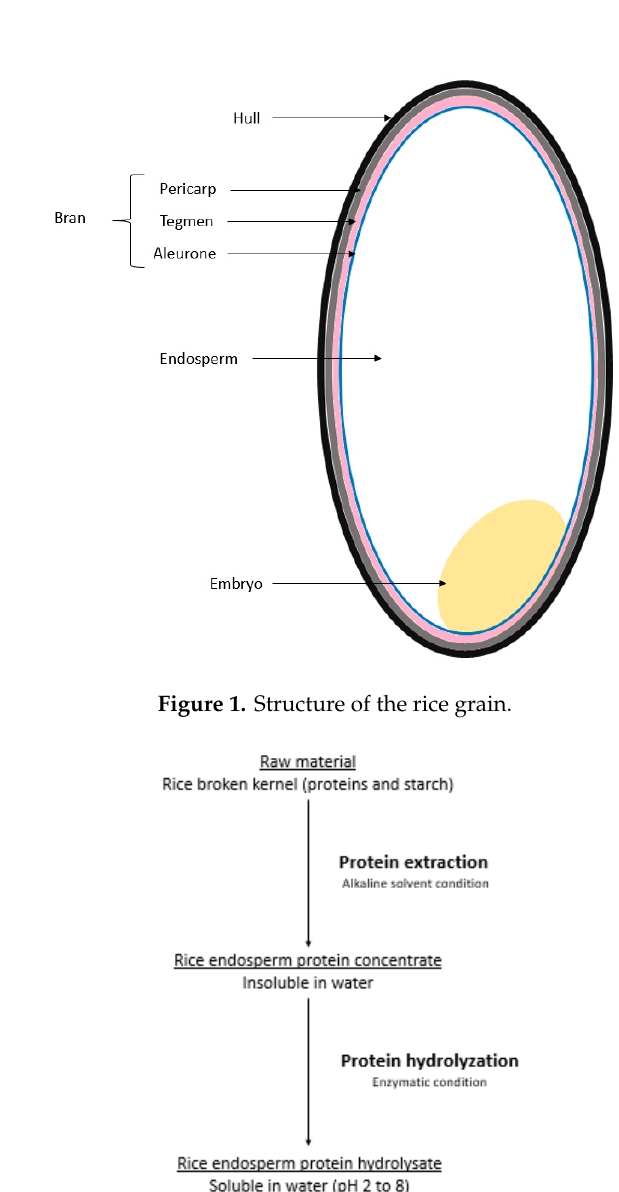
Figure 2. The two steps manufacturing process of the hydrolyzed rice protein raw material.